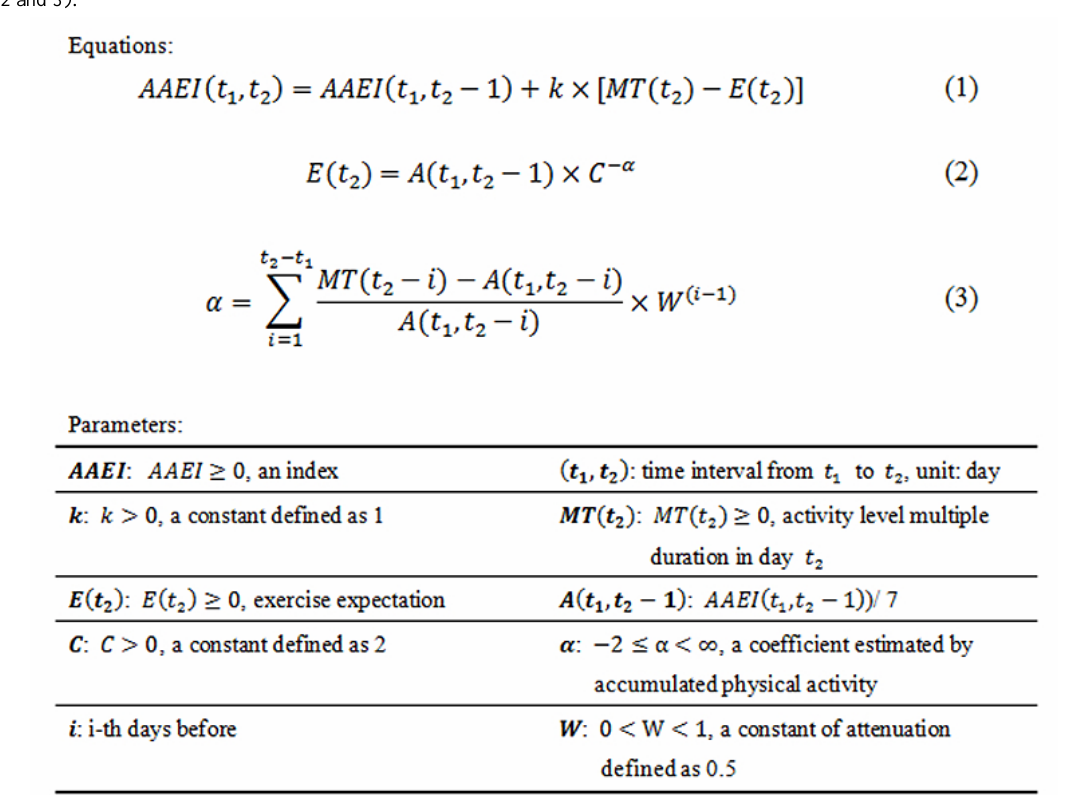
Figure 1. The accumulated activity effective index (AAEI) parameters and equations for the evaluating process (equation 1) and exercise expectance (equations 2 and